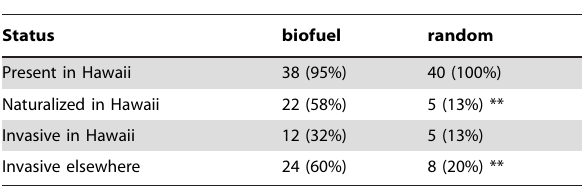
Table 2. Numbers (percentages) of species falling into the WRA risk categories within a group of species proposed as biofuels and a random selection of introduced species in